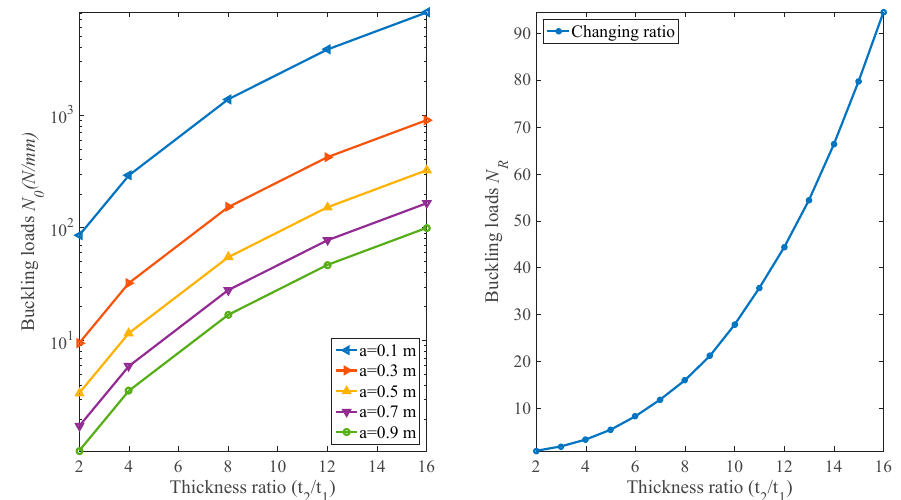
Figure 9. Buckling loads affected by the thickness ratio of the core layer.